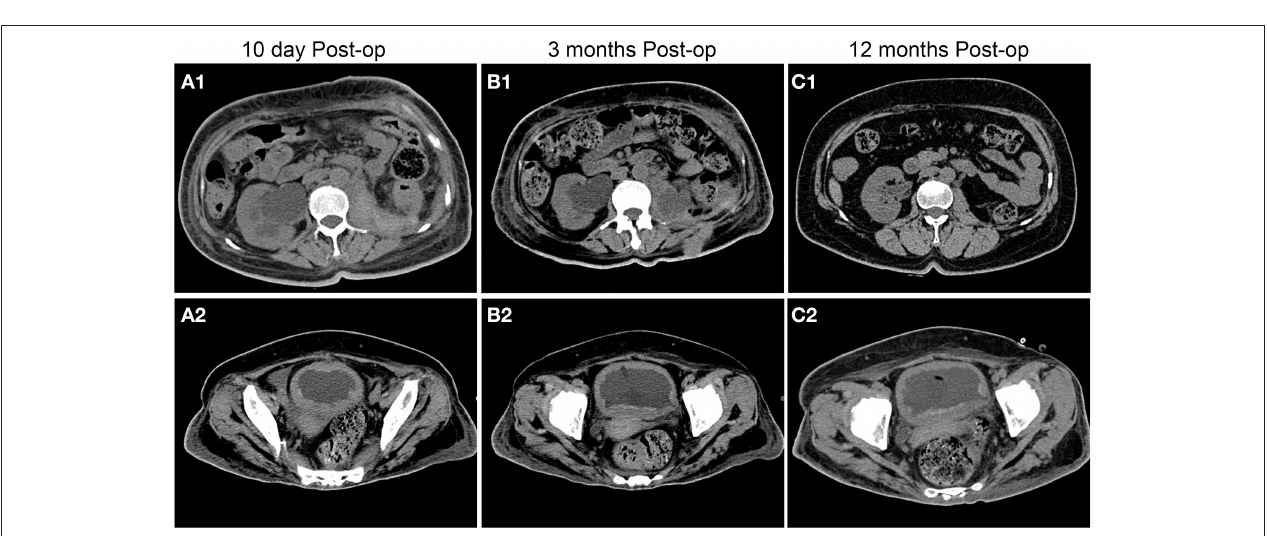
FIGURE 7 | Postoperative follow-up of patients with urinary CT findings. With the extension of time, the right hydronephrosis was gradually relieved, the renal function was gradually improved, and the bladder wall thickening was also significantly improved compared with the preoperative condition.